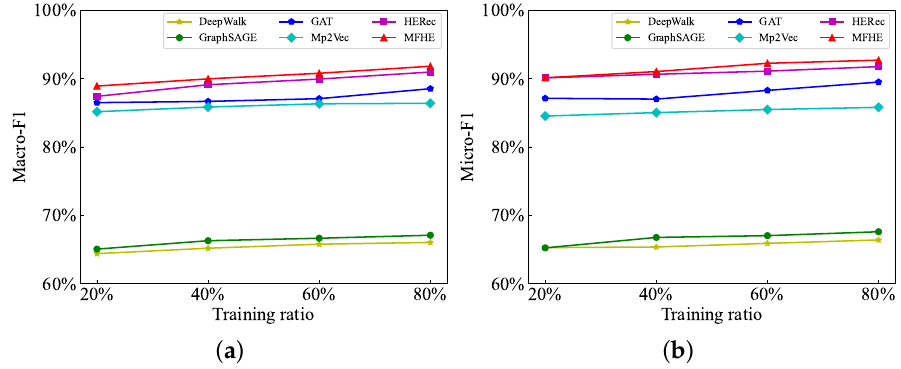
Figure 6. Node classification results on the DBLP dataset. ( a ) Macro-F1. ( b )